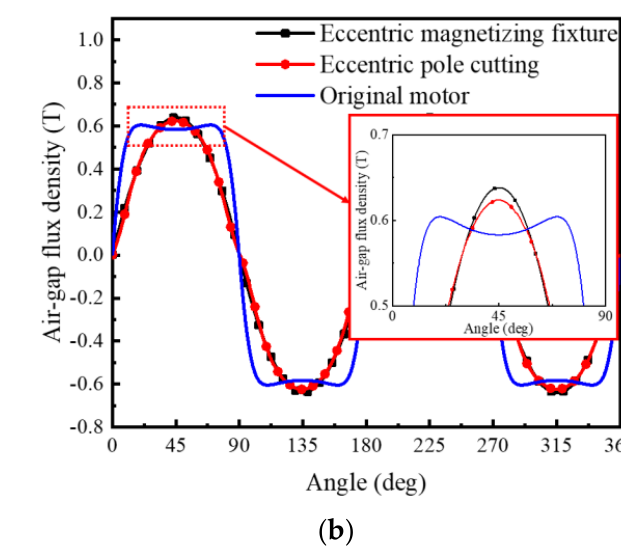
Figure 7. ( a ) Test structure diagram. ( b ) Air−gap flux density comparison. The schematic diagram of two kinds of bonded magnetic rings in the motor is shown in Figure 8.